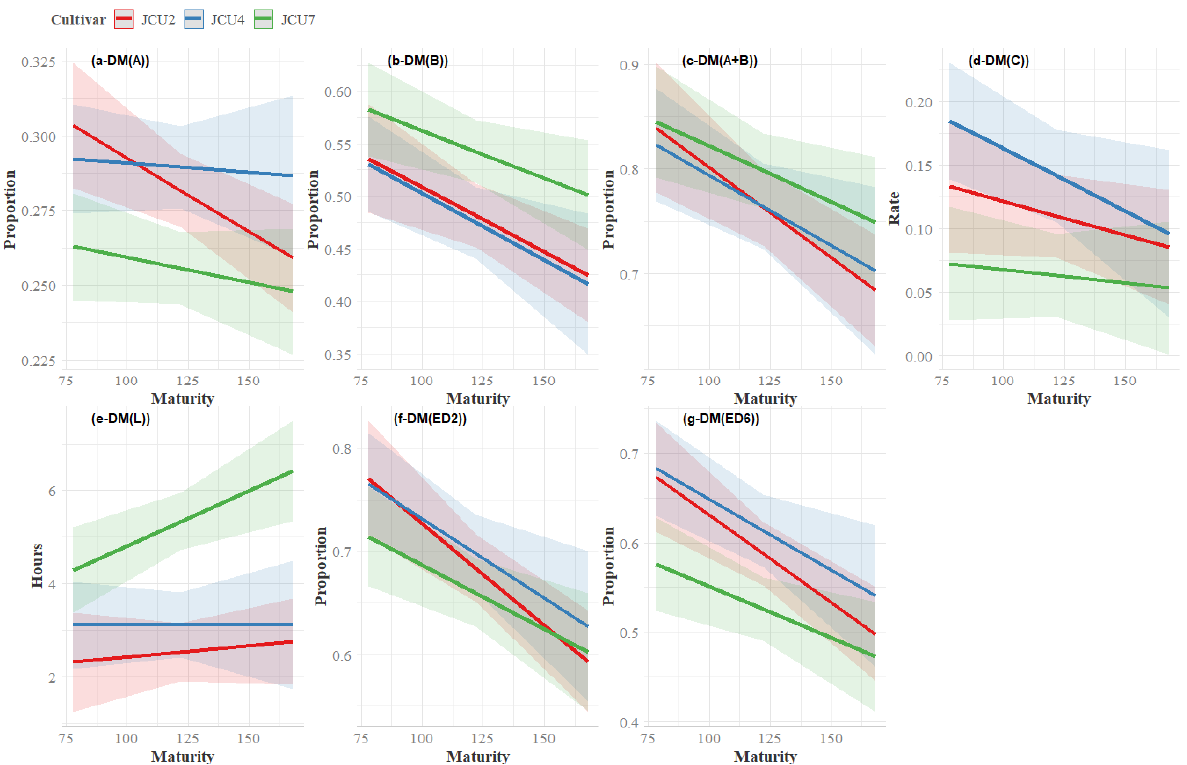
Figure 4. Effect plots for the change in in situ dry matter (DM) degradation of D. virgatus (JCU2), D. bicornutus (JCU4) and D. leptophyllus (JCU7) with maturity. ( a ) A; highly soluble fraction, ( b ) B; potentially degradable fraction, ( c ) A + B; total potentially degradable fraction, ( d ) C; rate of degrada- tion of fraction B, ( e ) L; lag time, ( f ) ED2; effective DM degradability with particle outflow rate of 2%/h and ( g ) ED6; effective DM degradability with particle outflow rate of 6%/h. No significant interactions between cultivar and maturity were observed ( p ≥ 0.17). Table 4. Effect of cultivar and maturity stage at harvest of desmanthus on in situ dry matter (DM) degradation. Data presented in fractions unless otherwise stated.